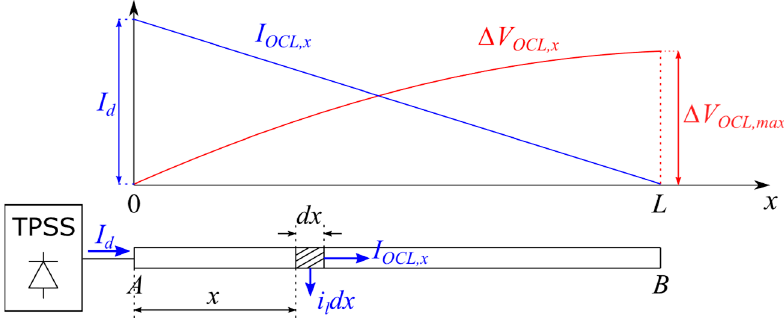
Figure 2. Unilateral power supply with a uniformly distributed load.